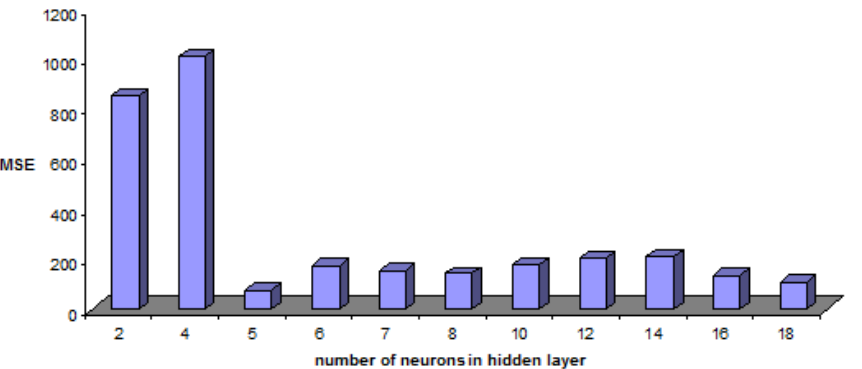
Fig. 8. Variation of MSE versus number of neurons in hidden